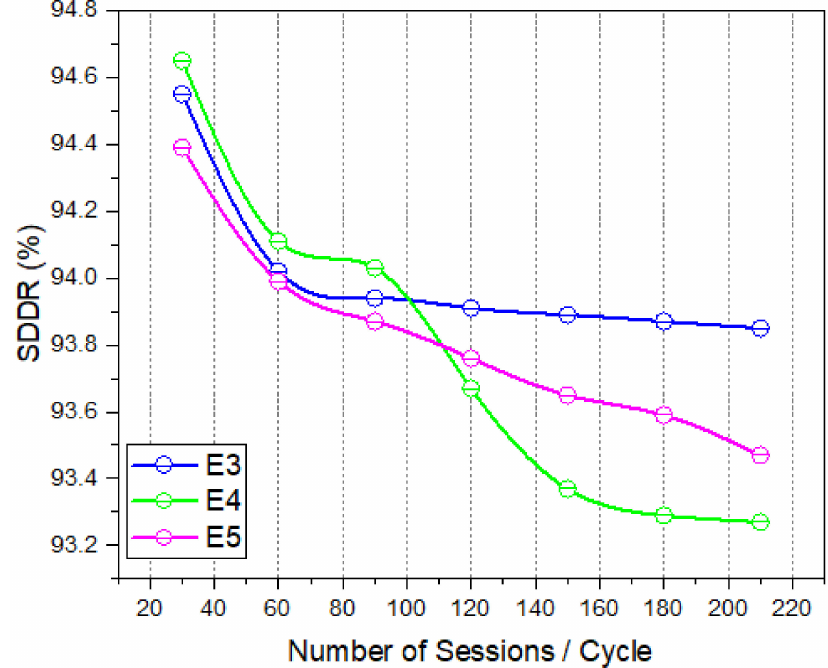
Figure 10. SDDR during the sessions.